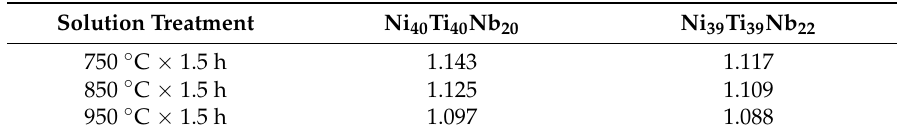
Table 2. The Ni/Ti ratio of NiTi phase in the eutectic structure of the Ni40Ti40Nb20 and Ni39Ti39Nb22 specimens. Solution